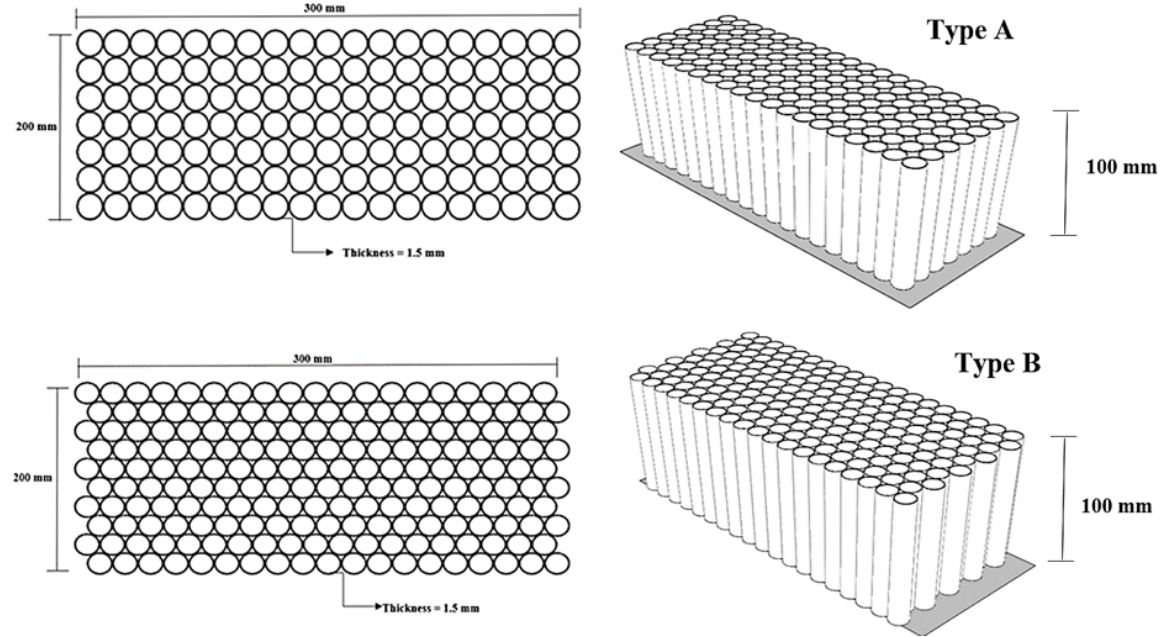
Figure 1: The width, length, height and thickness of circular honeycomb Core with square structure (Type A) and circular honeycomb Core with star structure (Type